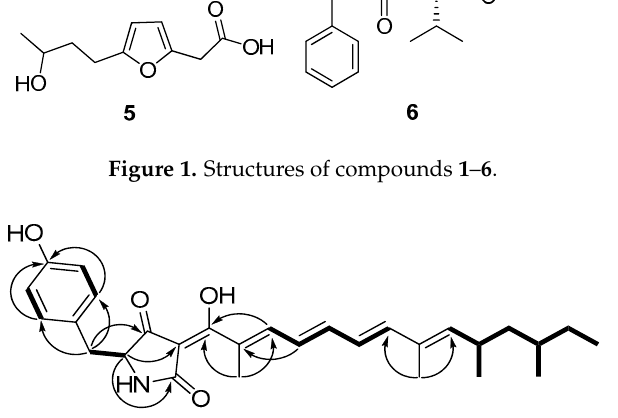
Figure 2. 1 H- 1 H COSY (bold) and key HMBC (arrow) correlations of fumosorinone A ( 1 ).